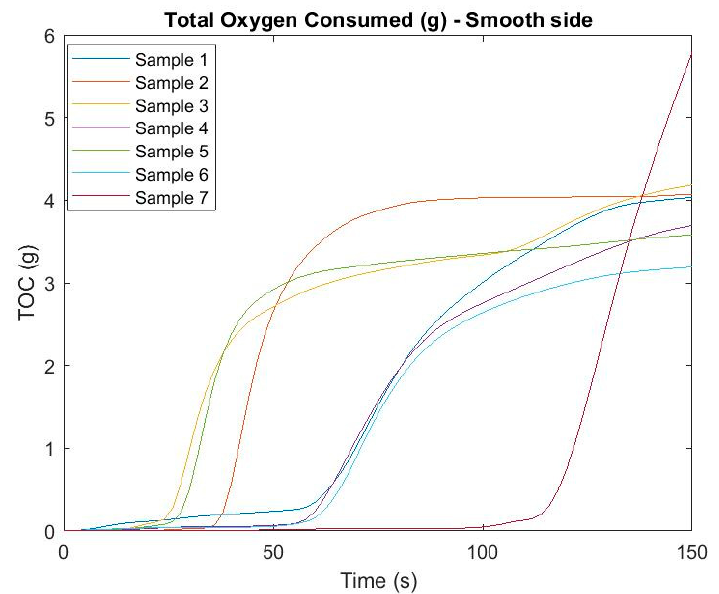
Figure 6. Total oxygen consumed (g) in time—smooth side.